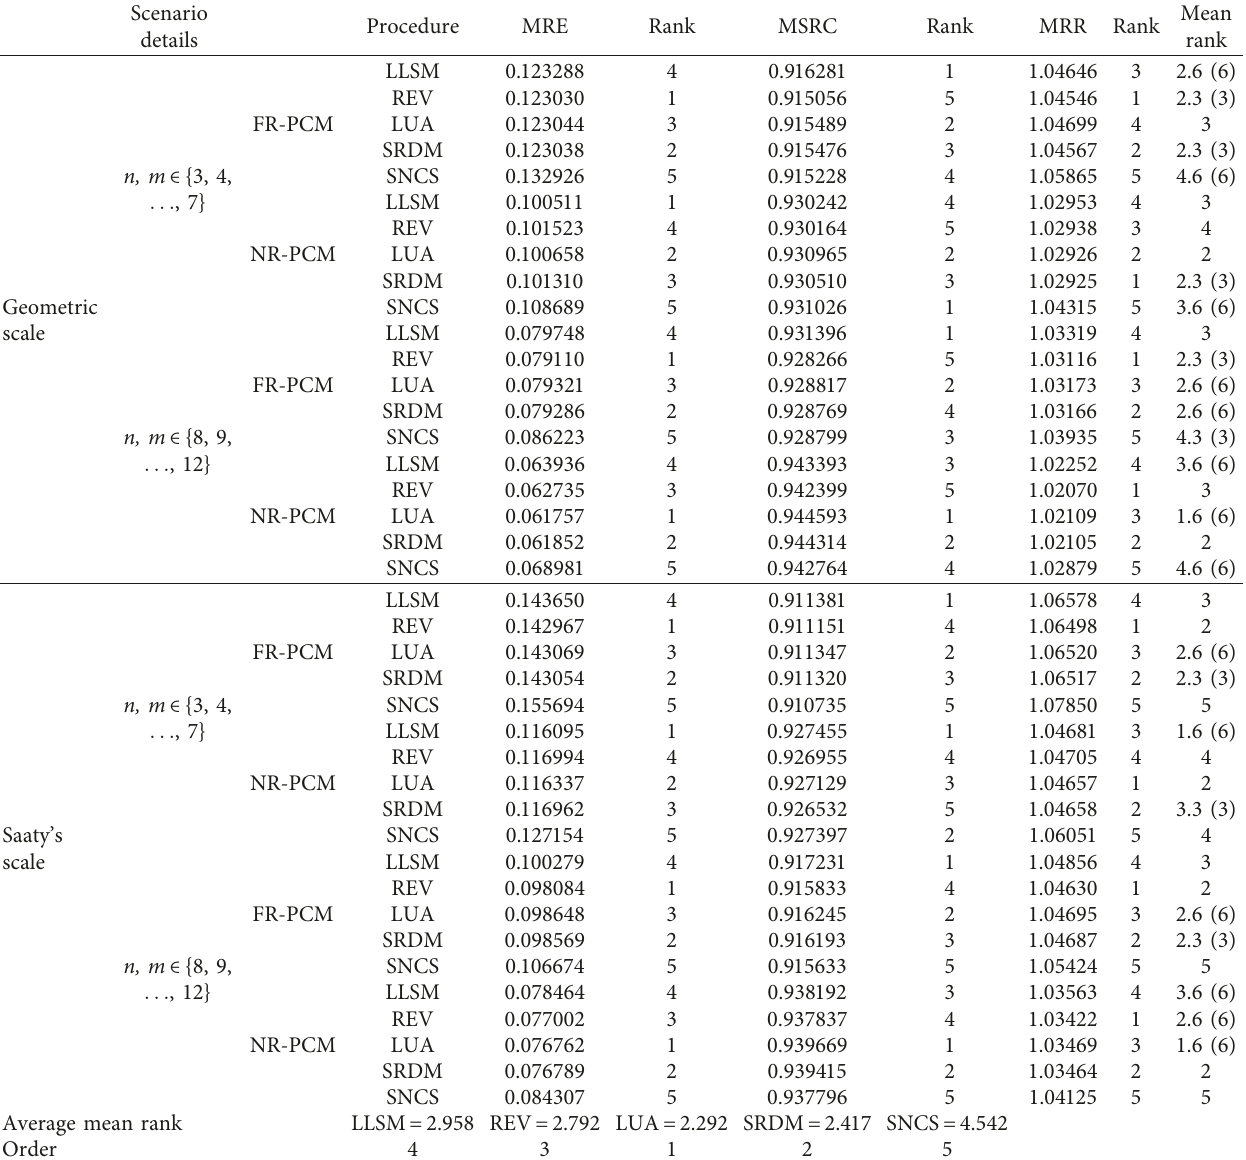
Table 5: Mean performance measures of arbitrarily selected five different approximation procedures for various uniformly drawn